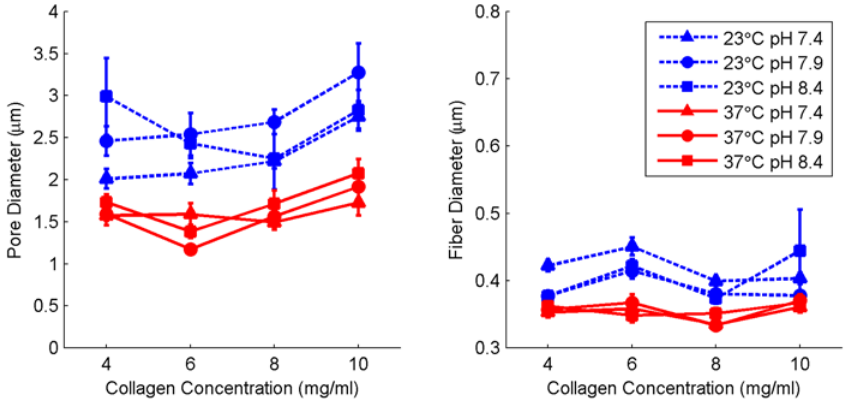
Fig 7. Pore and fiber diameter of collagen hydrogels. Blue symbols with dashed lines represent hydrogels polymerized at 23°C while red symbols with solid lines represent hydrogels polymerized at 37°C. Data shown are mean + SE with N = 12. Significance was calculated for pH-averaged groups. At each concentration, the difference between means at T = 23°C and T = 37°C is significant at p < 0.0001 for both pore diameter and fiber diameter.